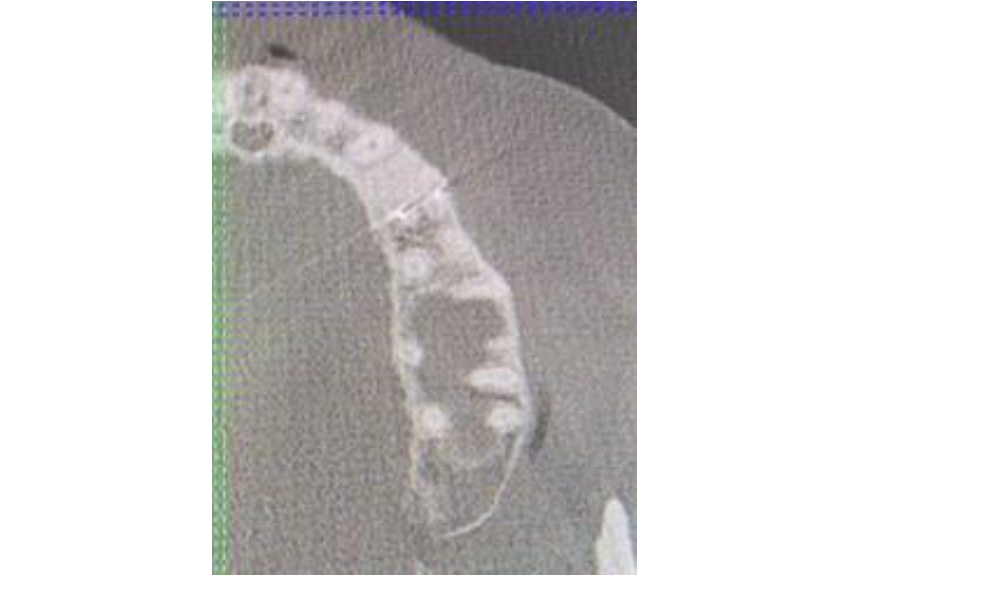
Figure 13. CBCT axial view after 15 months after